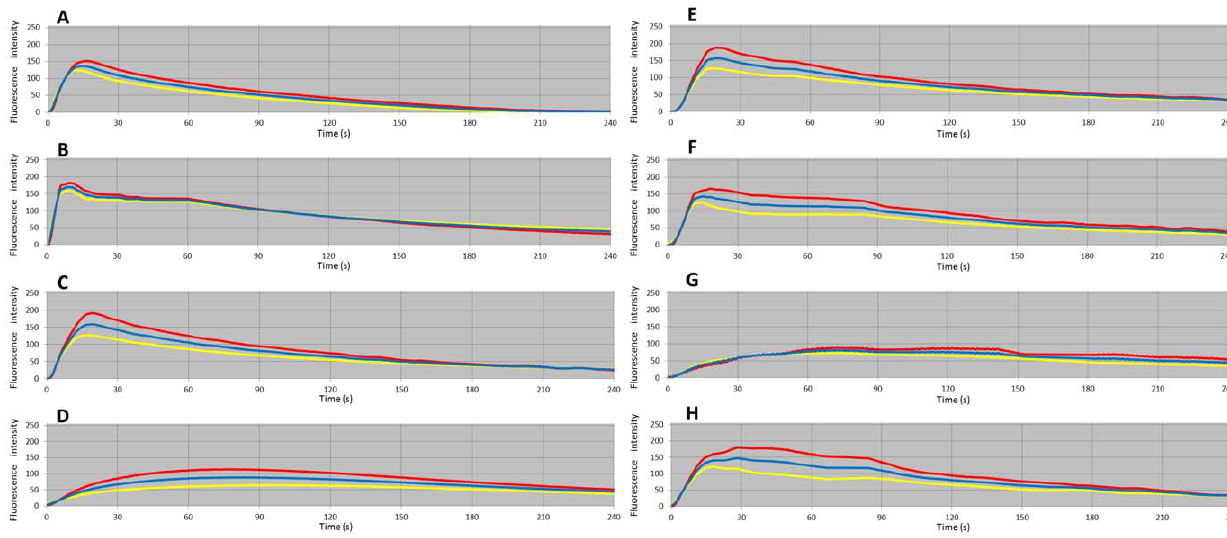
Figure 4. Time-intensity curves for different patterns of vessels for uterine perfusion. A Bilateral uterine + ovarian + vaginal vessels. B Bilateral uterine + ovarian vessels. C Bilateral uterine vessels. D Bilateral ovarian vessels. E Right uterine vessel + right ovarian vessel. F Right uterine vessel + left ovarian vessel. G Right ovarian vessel, H right uterine vessel. Red: uterine corpus, yellow: uterine cervix, blue: average of uterine corpus and cervix.